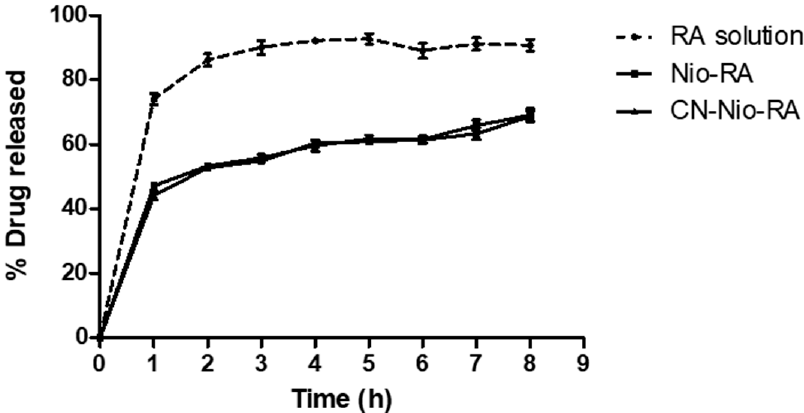
Figure 1. Amount of rosmarinic acid (RA) (%) released from free drug solution (RA solution), uncoated niosomes loaded with rosmarinic acid (Nio-RA), and chitosan and nutriose-coated niosomes loaded with RA (CN-Nio-RA). The study was carried out using dialysis bag method at 37 °C, and dissolution medium containing PBS (10 mM) with 300 mM NaCl (pH 7.0). All data represent mean ± SD (n = 3).